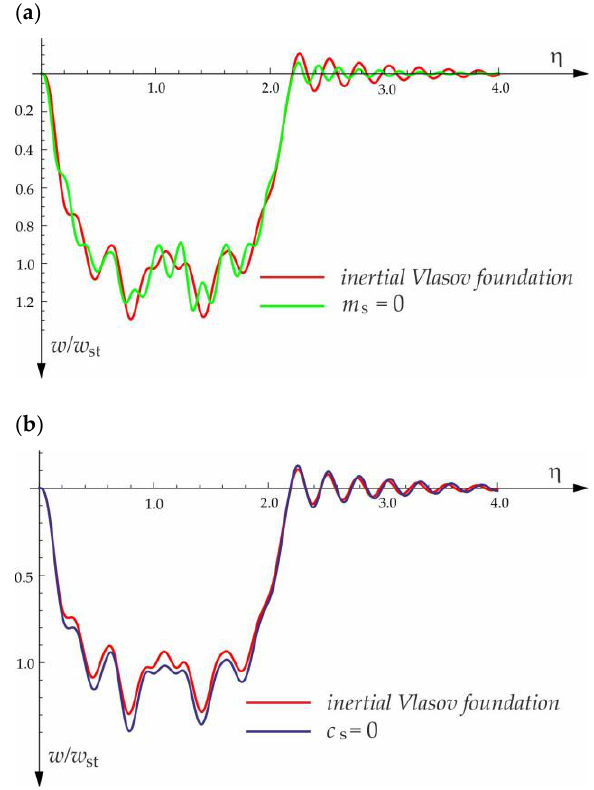
Figure 18. Influence of foundation parameters on the deflection of the midpoint of the beam subjected to the group of three forces moving at a velocity of v = 50 m/s and a distance of a = 3 m: ( a ) mass coefficient, ( b ) shear coefficient.